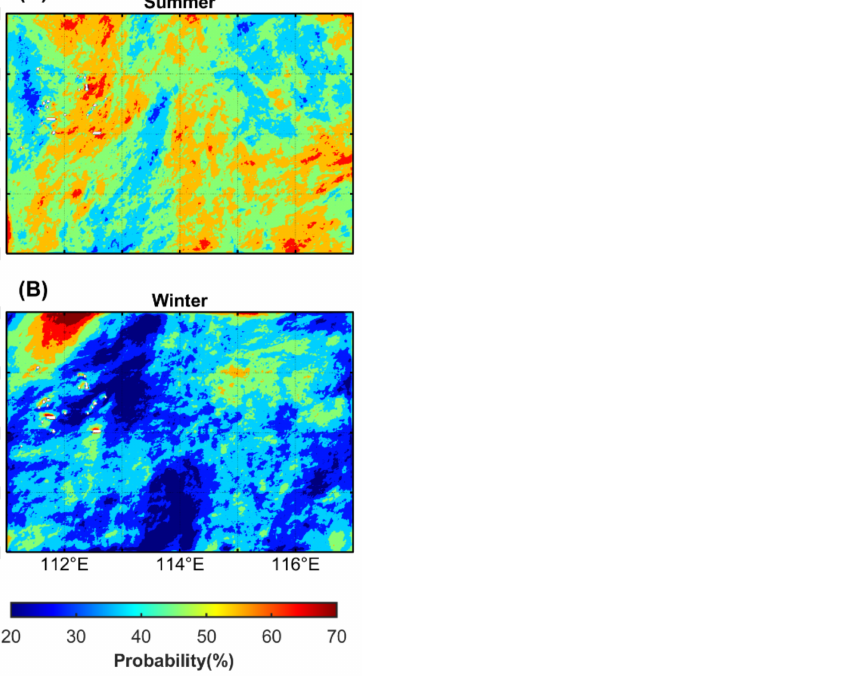
Figure 10. Spatial distributions of the occurrence probability of EBF > 0 on the sea surface. The panel ( A , B ) shows averaged results in July (January) from 2017 to 2019, representing summer (winter).